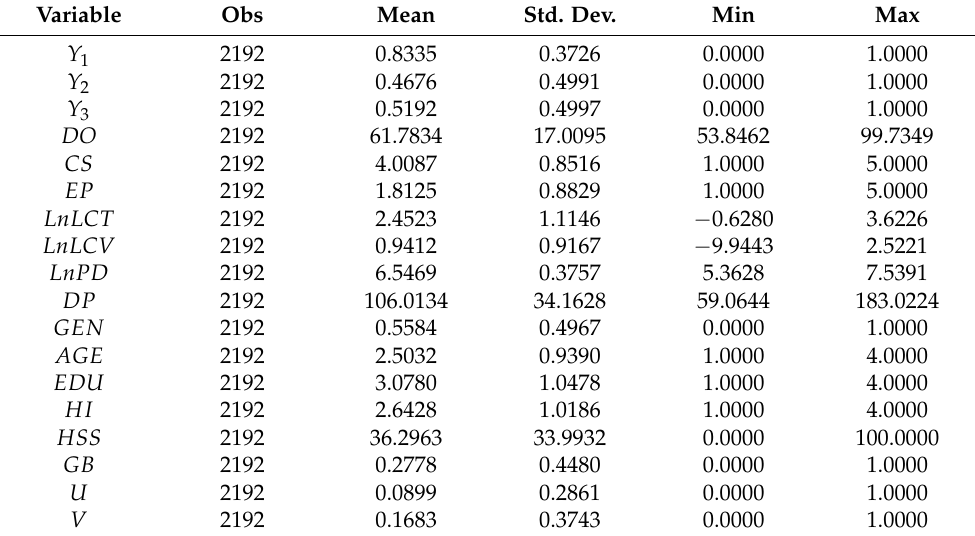
Table 4. Descriptive statistics of the variables.